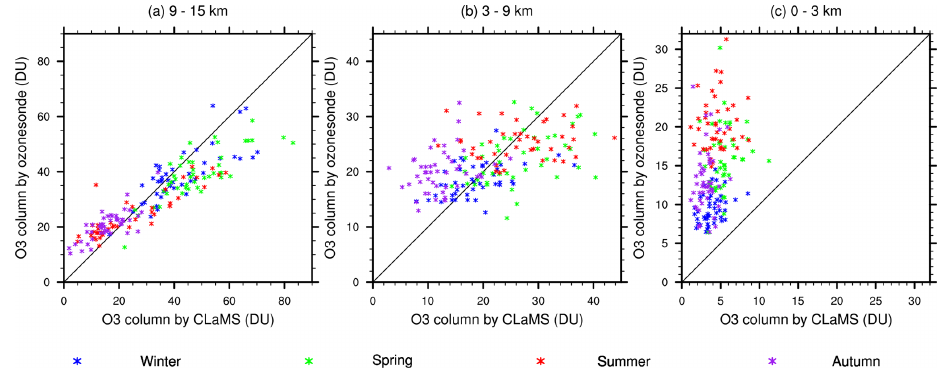
Figure 2. Validation of ozone columns simulated by CLaMS (in Dobson units, DU) by comparison with the IAP ozonesonde in (a) the UTLS, (b) the mid-troposphere and (c) the lower troposphere during 2012–2018. Each point represents the average of 1 month of measure- ments. Measurements in different seasons (winter: December–January–February; spring: March–April–May, summer: June–July–August; and autumn: September–October–November) are shown in different